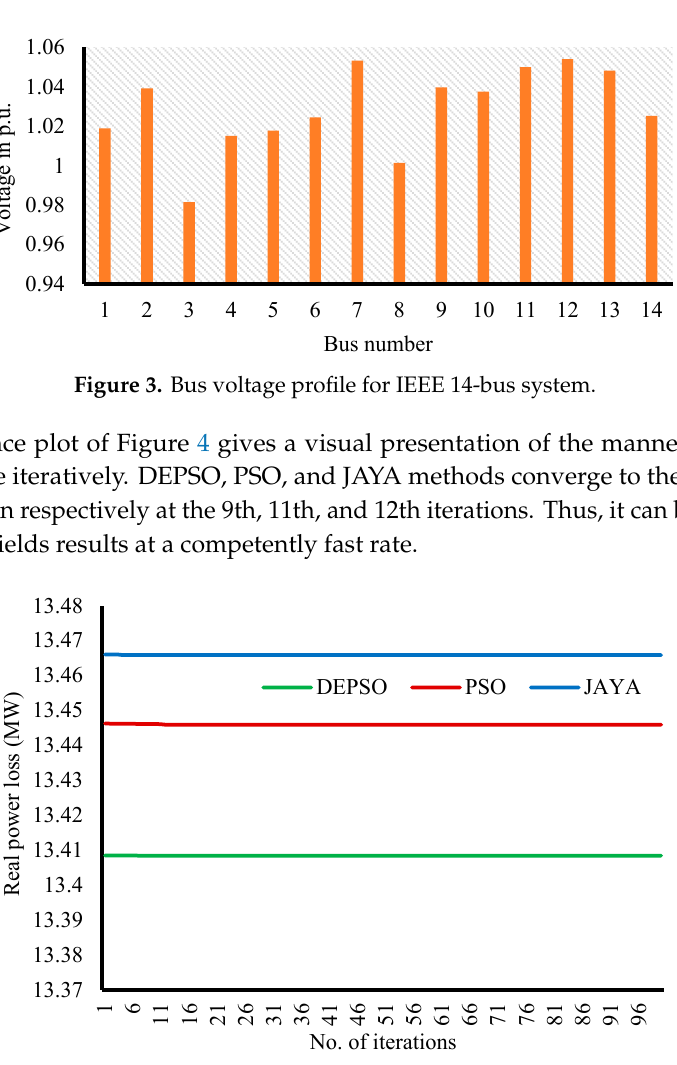
Table 4. Optimal control variables for IEEE 30-bus using different algorithms.